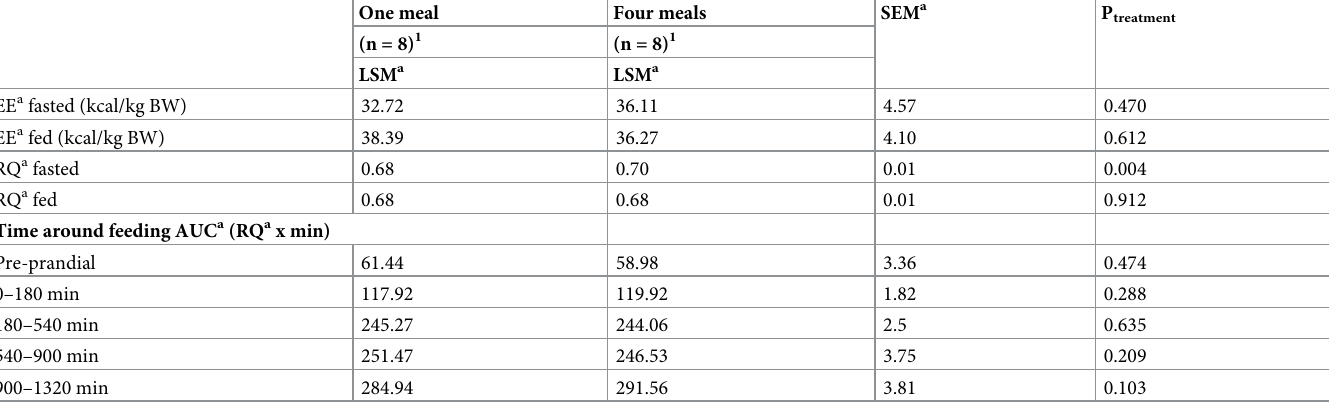
Table 7. Energy expenditure (kcal/kg BW), respiratory quotient, and area under the curve for the respiratory quotient of cats eating once (0800 h) or four times (0800 h, 1130 h, 1500 h, 1830 h) daily over a 24-h period. One